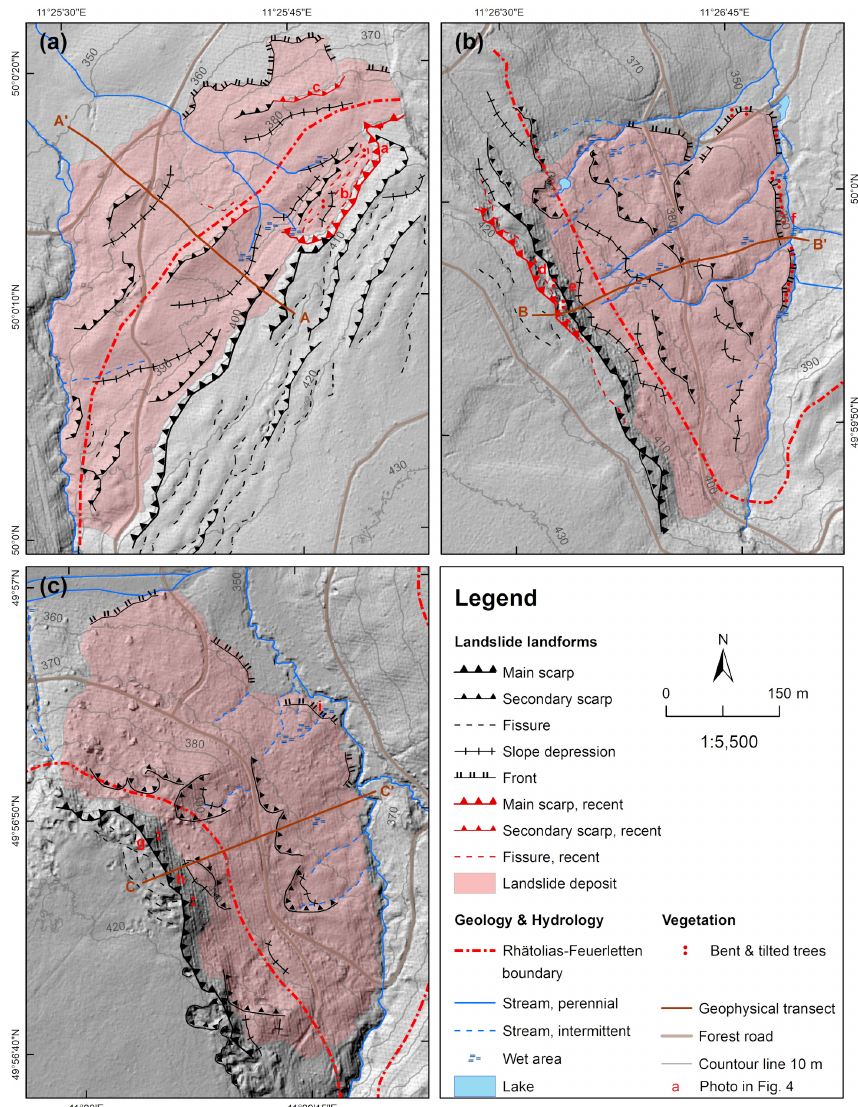
Figure 3. Geomorphic maps of the landslides at (a) Putzenstein, (b) Weinreichsgrab and (c) Fürstenanger (DEM source: Bayerische Ver- messungsverwaltung). For the location of landslides within the research area see Fig.